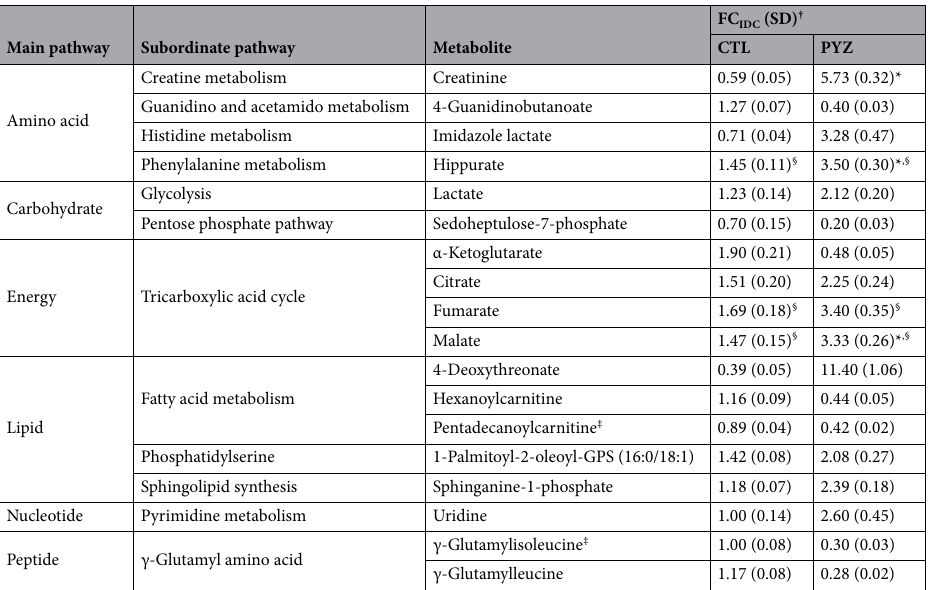
Table 2. List of significantly altered metabolites due to treatment by a pyrazoleamide drug. CTL uRBC and iRBC cultures maintained in pure RPMI medium, IDC intraerythrocytic developmental cycle, iRBC parasite- infected RBC, GPS glycerophosphoserine, PYZ uRBC and iRBC cultures maintained in RPMI medium with a sublethal dose of a pyrazoleamide drug, RBC red blood cell, RPMI Roswell Park Memorial Institute, SD standard deviation, uRBC uninfected RBC. † Fold-change (FC IDC ) values based on a comparison of the average normalized abundance of a metabolite during the IDC in the iRBC culture relative to that in the uRBC culture. The standard deviation (SD) represents deviation from the mean of 10,000 bootstrap samples (see